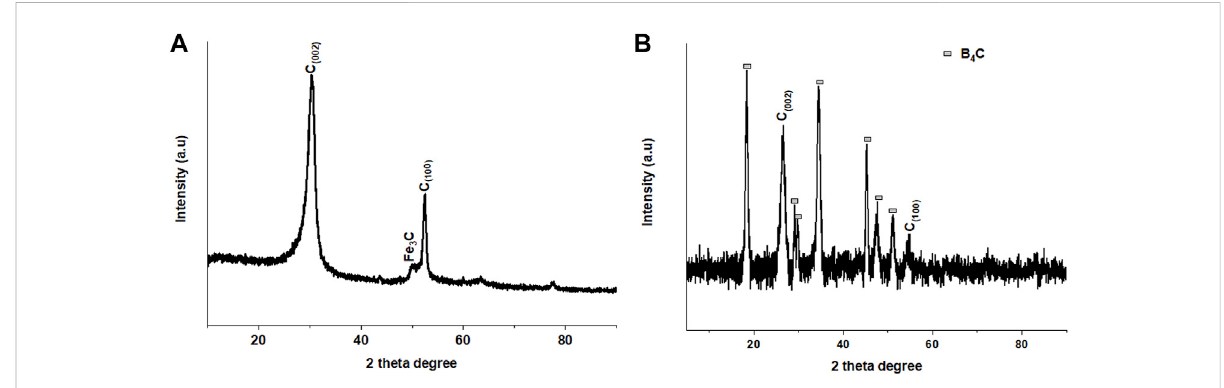
FIGURE 5 X-ray diffraction patterns of chlorinated CNTs (A) and CNMs generated from dichlorobenzene and triphenylborane as chlorine and boron sources, respectively (B)